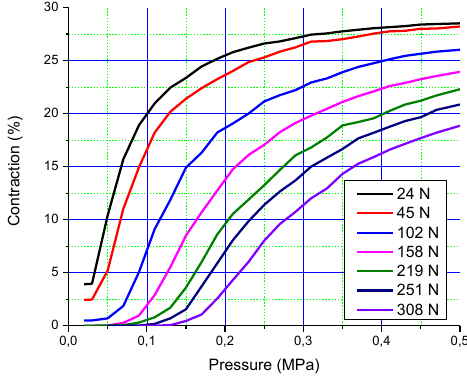
Fig. 8. The isotonic characteristics of the pneumatic artificial muscle